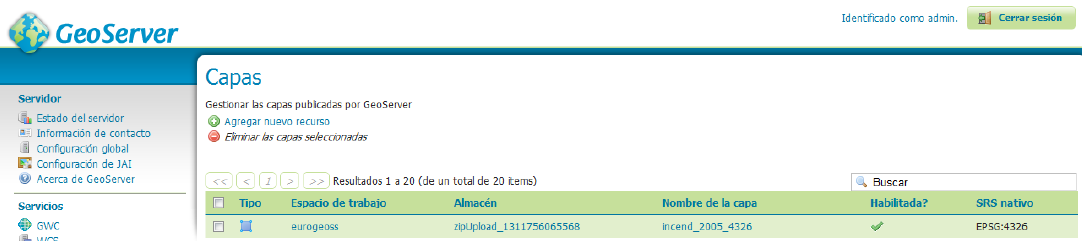
Figure 11. Screenshot of the data published in Geoserver